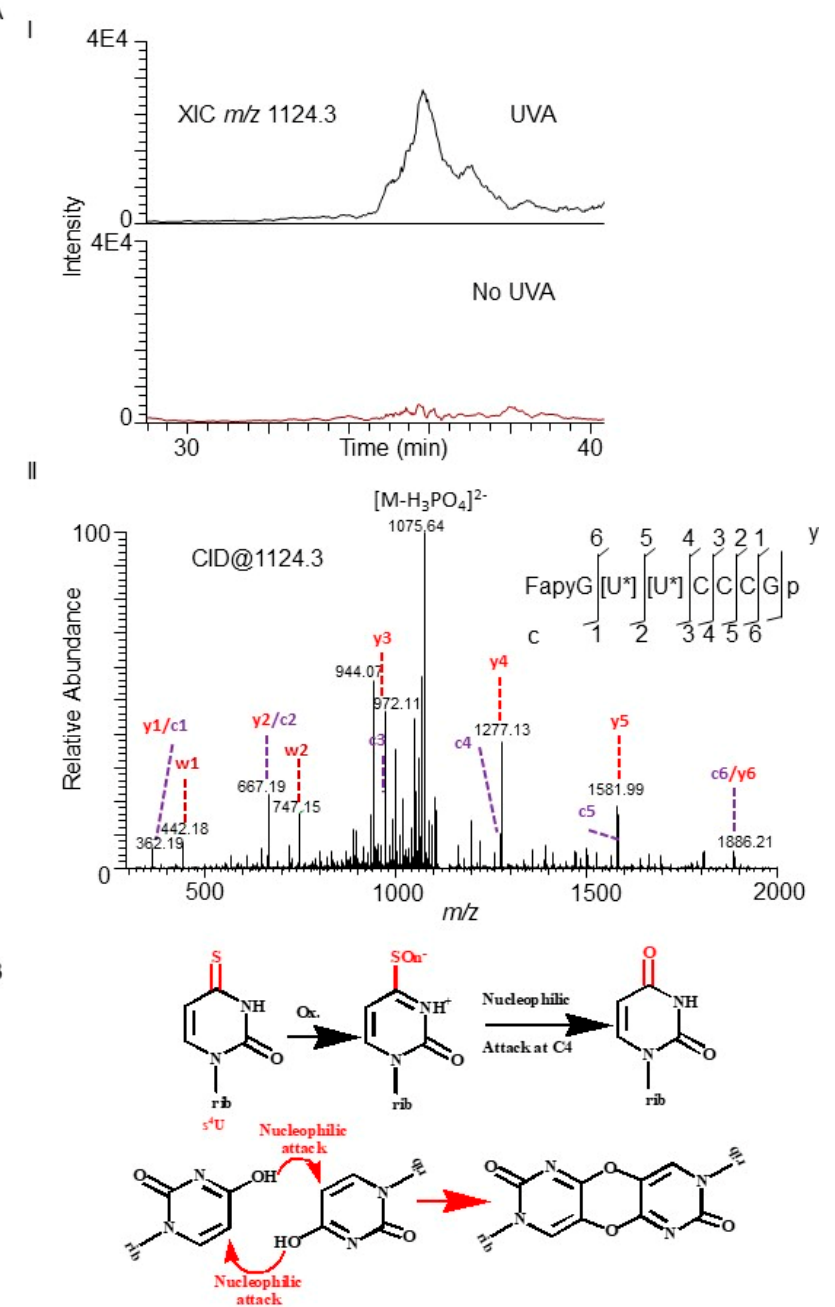
Figure 2. Detection of oligonucleotide containing diuridine crosslink and oxidized guanosine following UVA exposure . ( A ) LC–MS detection of the oligonucleotide FapyG[U]*[U]*CCCGp ( m/z 1124.3, position 7-13) from UVA-exposed E. coli tRNA Tyr. (I) Extracted ion chromatogram (XIC) for m/z 1124.3 in the exposed and unexposed samples. (II) Tandem (MS/MS) mass spectrum of m/z 1124.3 depicting the sequence informative product ion pattern (cn-ion series for 5 ′ and yn/wn ion series for 3 ′ -end are depicted in purple and red color) of precursor oligonucleotide anion. [U*][U*]-diuridine crosslink, FapyG- formamidopyrimidine-Guanine ( B ) Potential mechanism of formation of 4-5 cross-linked diuridine photoproduct. The chemical group -SO n- represent either sulfenic (U-SOH) or sulfinic (U-SO 2 H) or sulfonic (U-SO 3 H) intermediates.